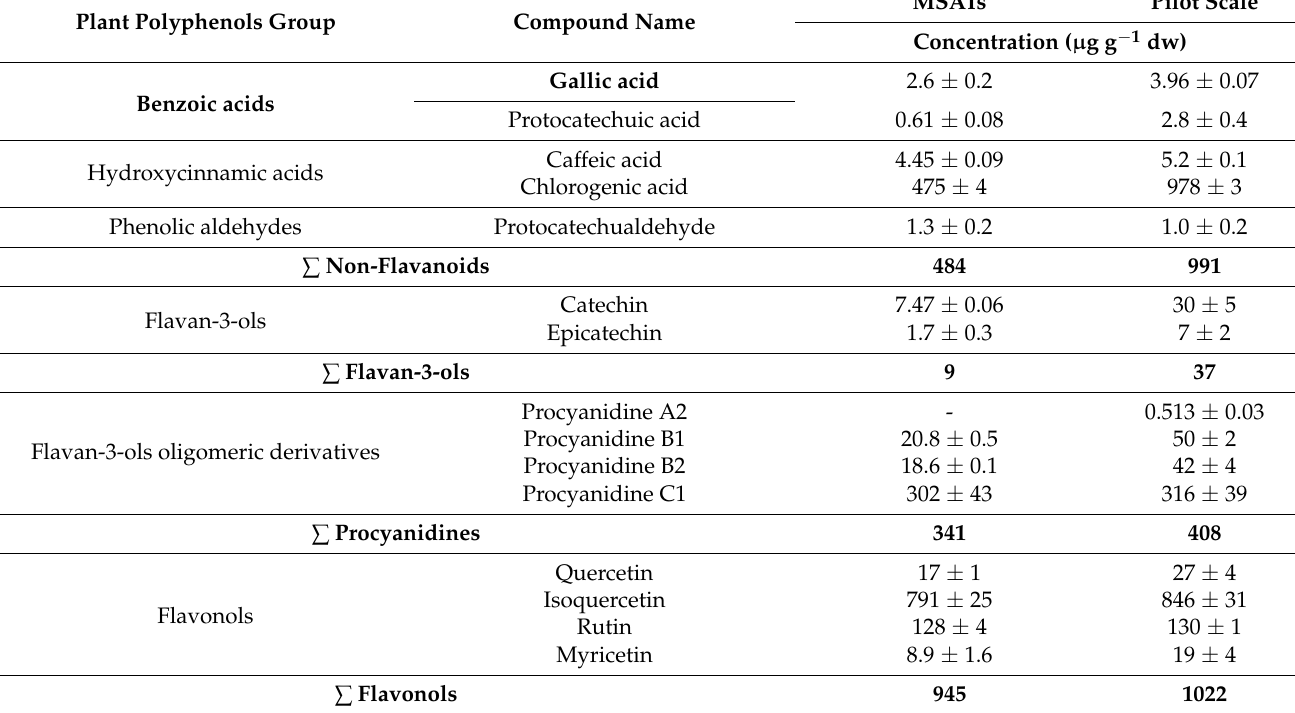
Table 2. Polyphenolic content of the saline blueberry extract (VcB) obtained by MSATs and at a pilot scale. Plant Polyphenols